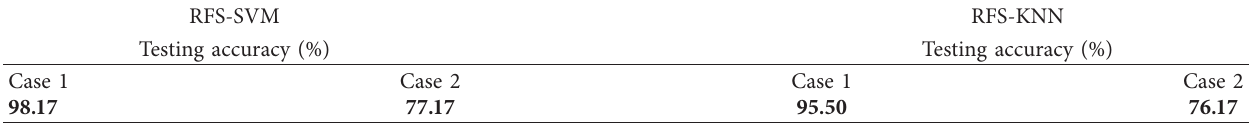
Table 14: The testing accuracies of RFS-SVM and RFS-KNN. RFS-SVM RFS-KNN